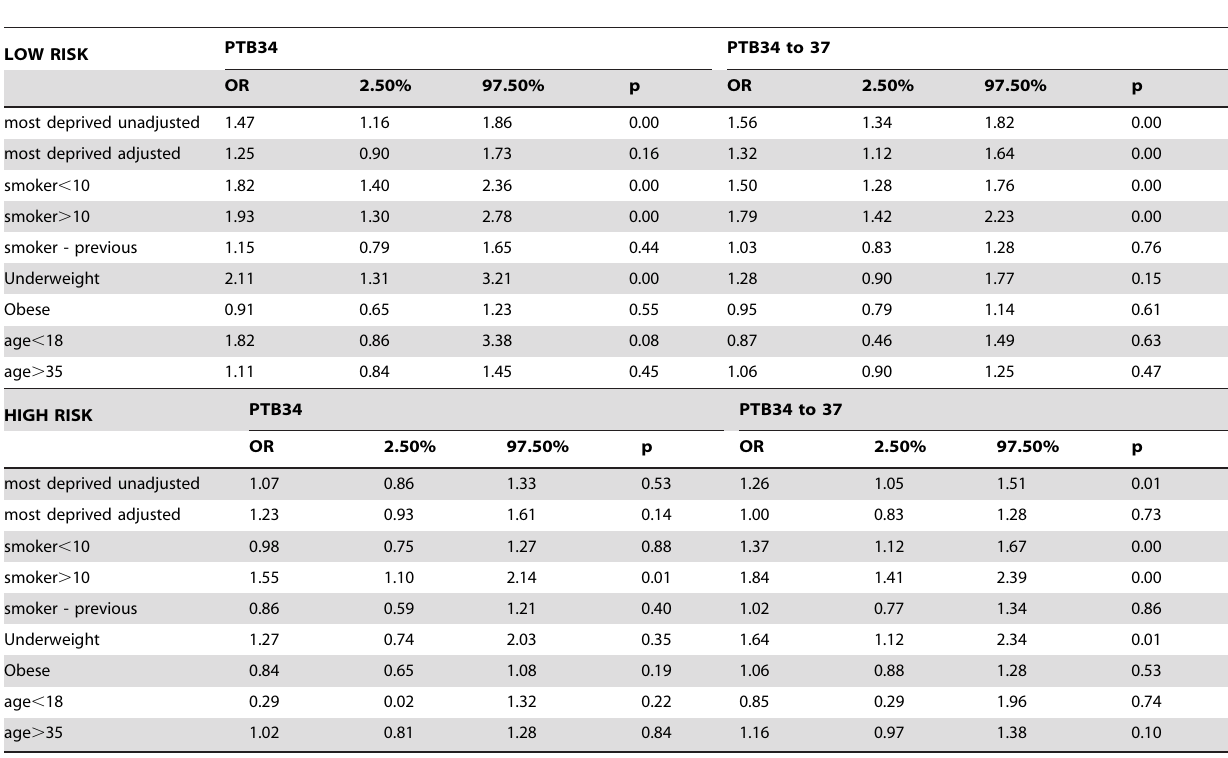
Table 3. Multivariate logistic regression models assessing independent association between covariates and PTB in low risk